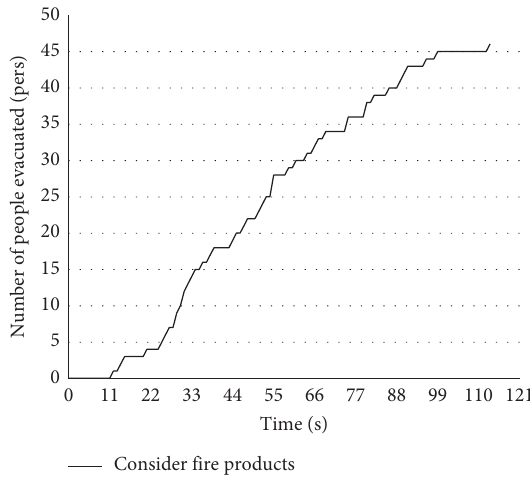
Figure 29: Exit 3 evacuation situation.